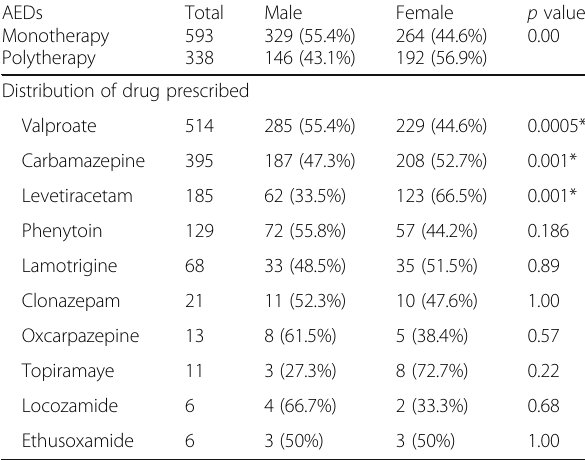
Table 4 Gender differences epilepsy etiologies